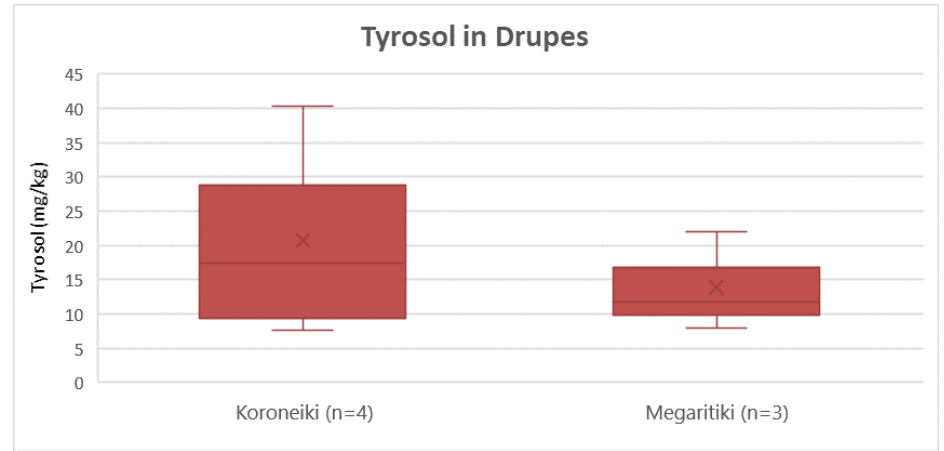
Figure 11. Box and whisker plot for the concentrations of tyrosol between different varieties of drupes.